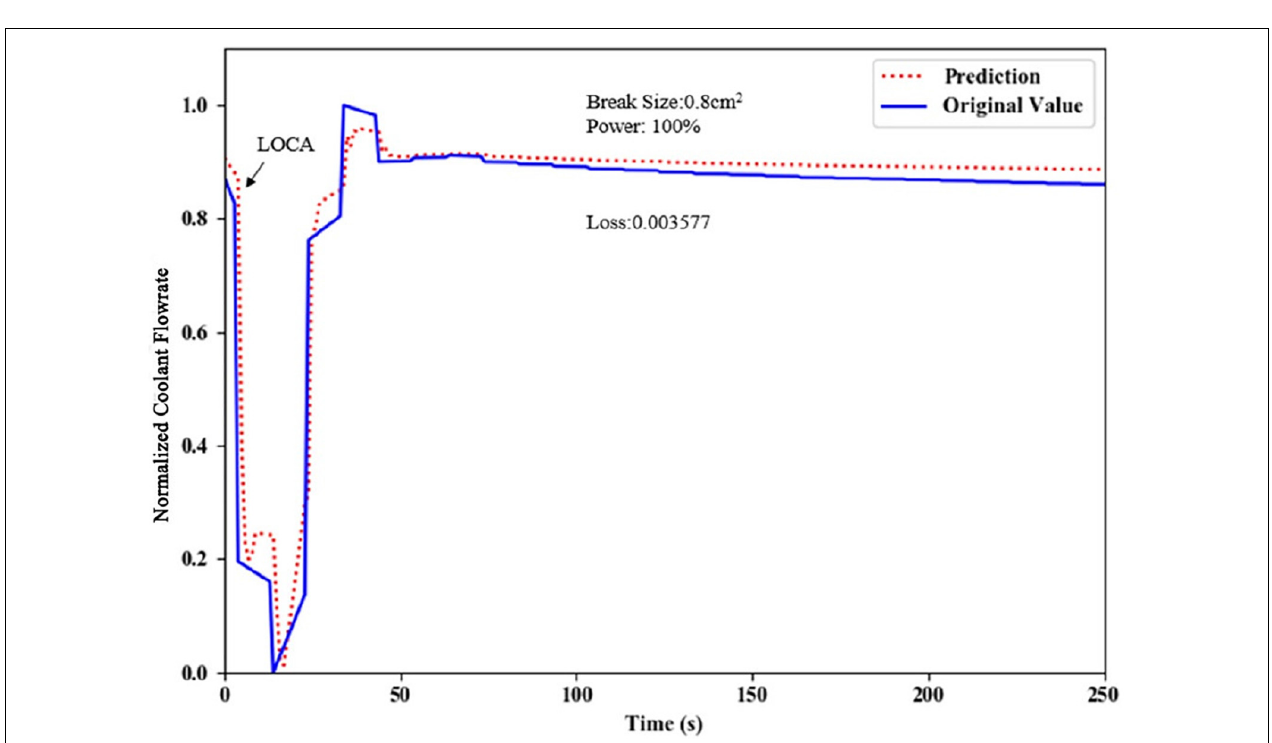
FIGURE 6 | Coolant flowrate prediction for 0.8 cm 2